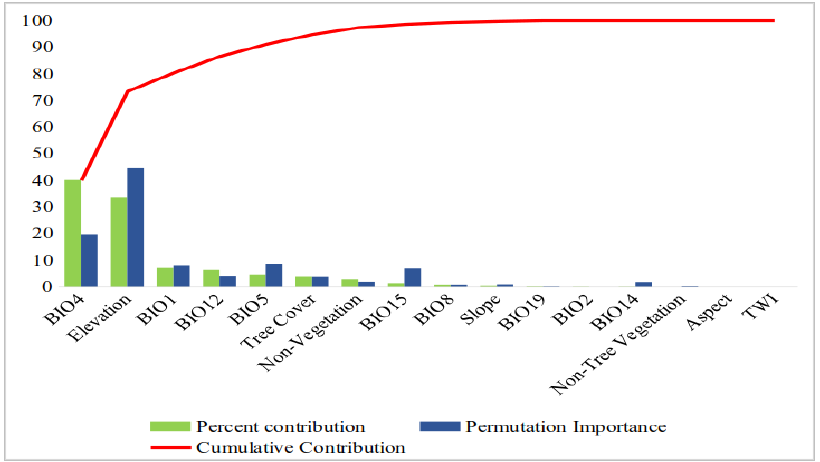
Figure 5. Importance of the considered environmental parameters on the performance of the MaxEnt model. Ent model.